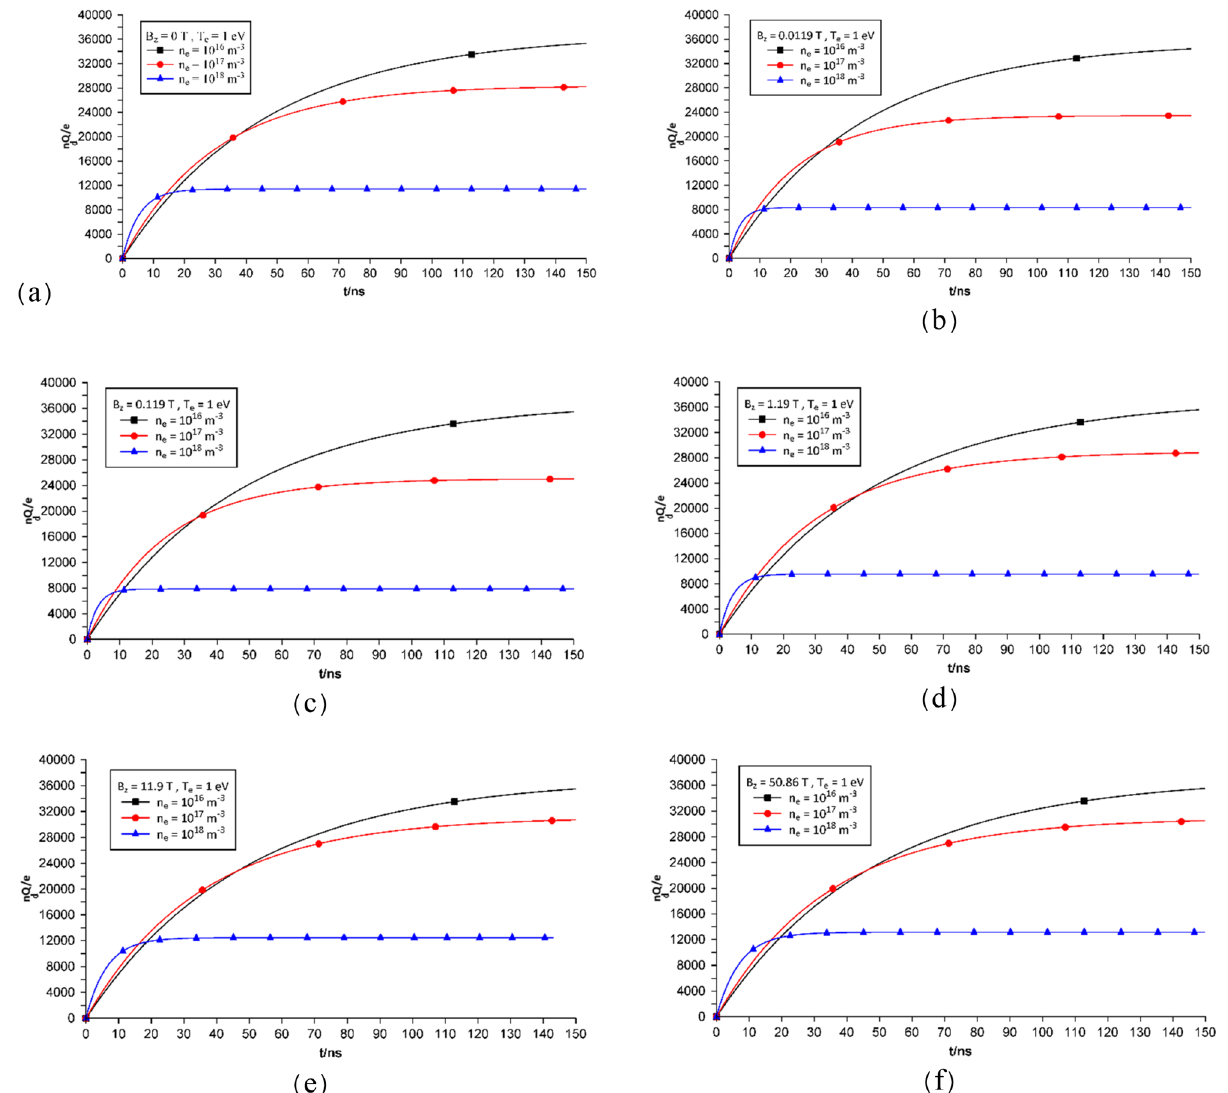
Figure 2. Time evolution of the dust particle charges with the same initial plasma density and temperature, and exposed to different magnetic field ( a ) B 0z = 0 T, ( b ) B 0z = 0.0119 T, ( c ) B 0z = 0.119 T, ( d ) B 0z = 1.19 T, ( e ) B 0z = 11.9 T, and ( f ) B 0z = 50.86